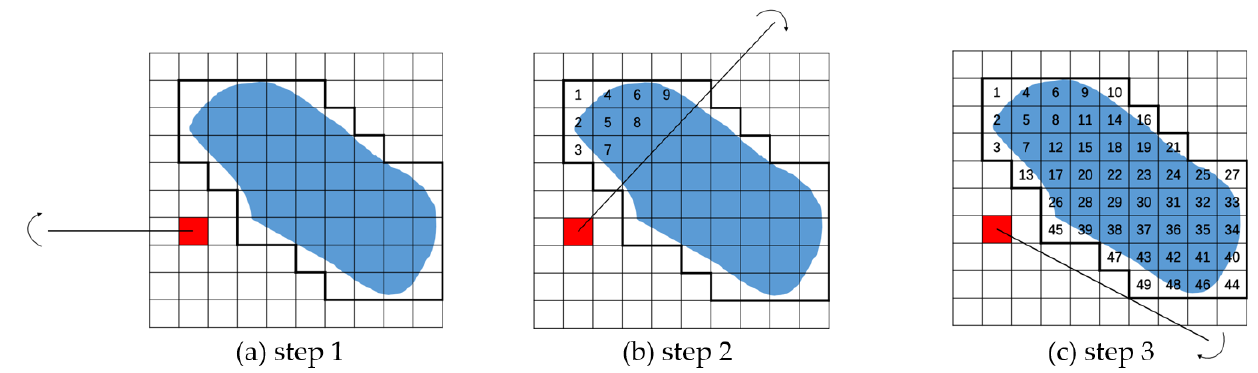
Figure 3. Scanning process of the target area. The red cell represents the take-off location.